Question: Summarize what this figure shows in one sentence.
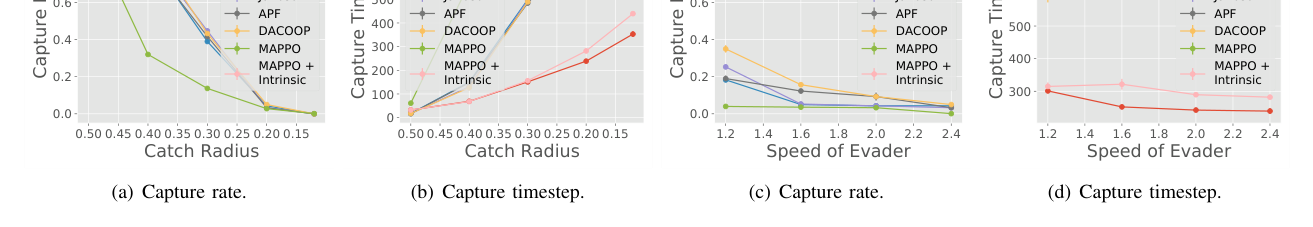
Answer: Results of DualCL and all baselines in Empty. DualCL achieves 100% capture rate and the shortest capture timestep with all combinations of intrinsic parameters.